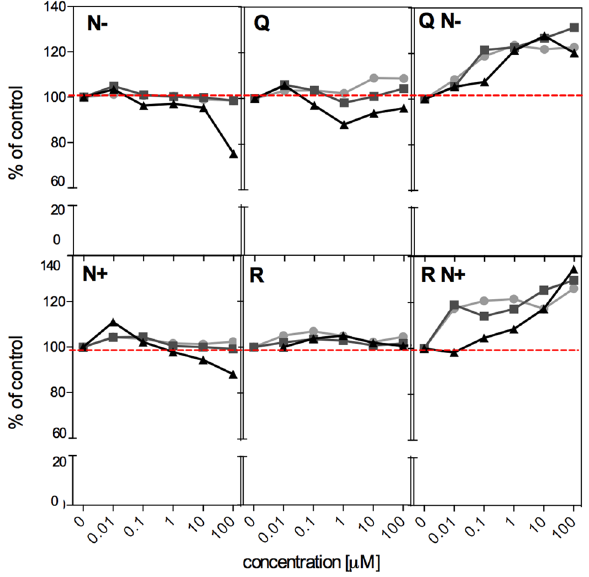
Figure 3. Inhibition of growth of HT29 cells determined by MTT test after 6 (circles), 24 (squares) and 72 h (triangles) exposure to individual flavonoids (0.01–100 μM) and their mixtures containing equal concentrations of each compound (0.01–100 μM). Results represent means of three independent experiments carried out in triplicates (for clarity SD values are not presented, but in all cases were lower than